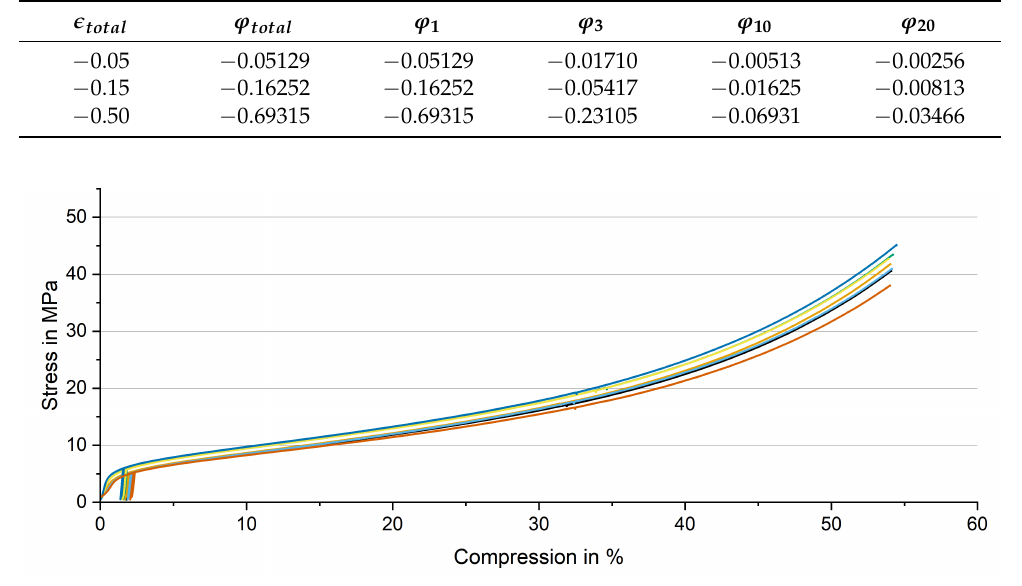
Figure A1. Results of compression tests of PA80-110, second measurement